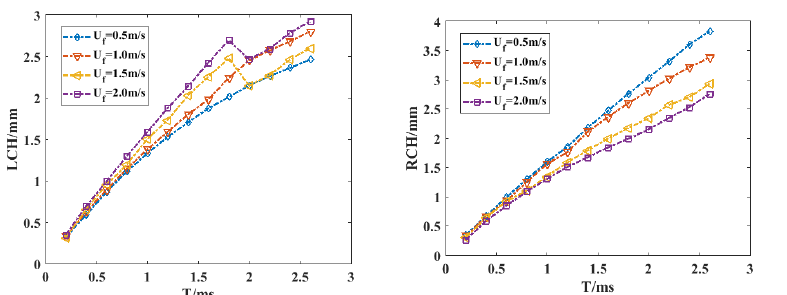
Figure 10. Crown heights of left and right at different dynamic film velocities when θ = 30 ◦